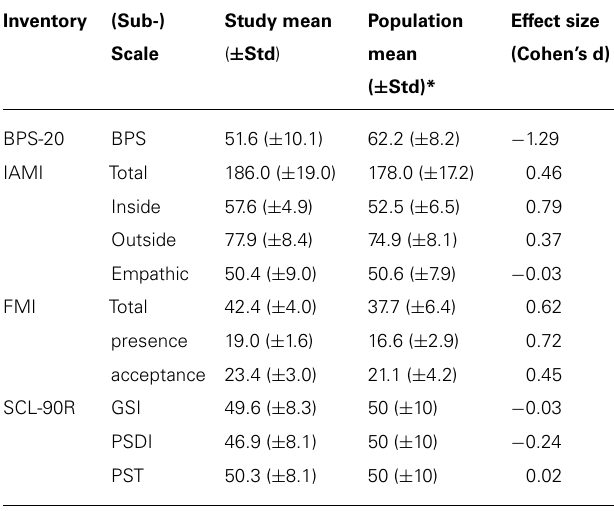
Table 5 | Results of the BPS-20, IAMI, FMI, and SCL-90R questionnaires from participants in the current study compared with the population mean.